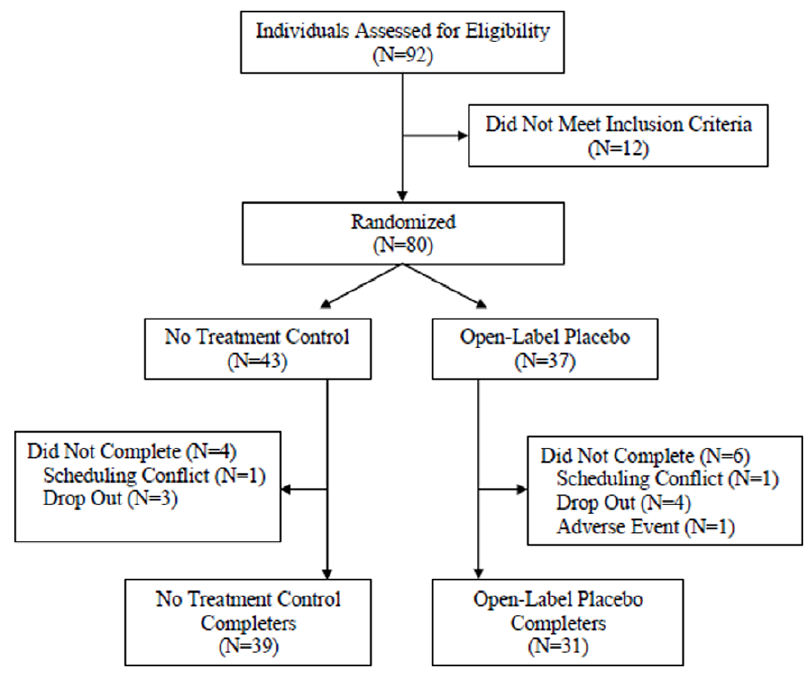
Figure 1. Enrollment Flowchart.